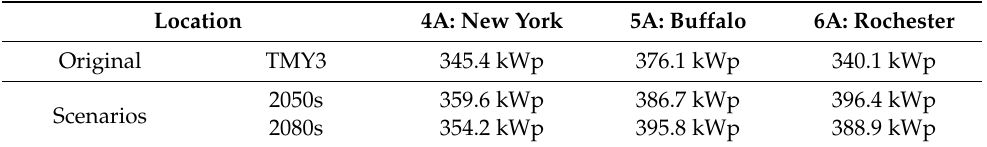
Table 6. Maximum power capacity of PV installations to enable NZCBs.